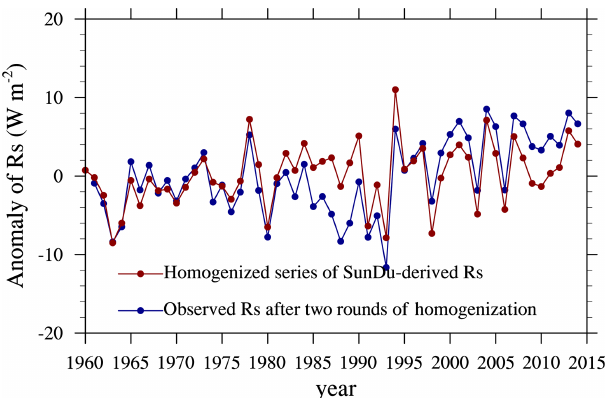
Figure 12. Time series of annual anomalies of the surface incident solar radiation ( R s ) based on R s observations after two rounds of homogenization (dark-blue line). The homogenized series of ob- served R s from 1961 to 1970 shown in Fig. 7 was tuned by the RHtests method again using the homogenized series of SunDu- derived R s (dark-red line in Figs. 7 and 10) as a reference.